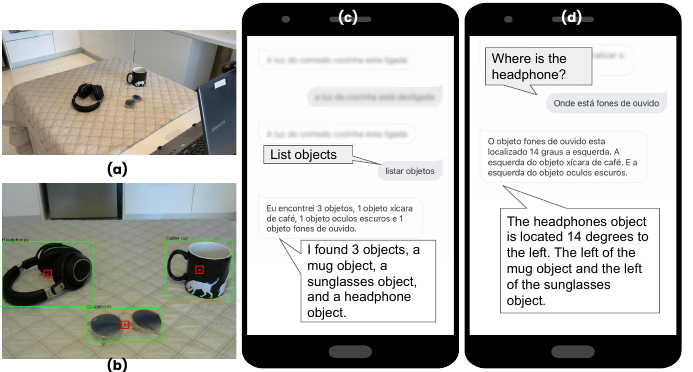
Figure 5. Homer execution ( a ) scenario, ( b ) scenario recognised by the camera, ( c ) find objects, and ( d ) find specific